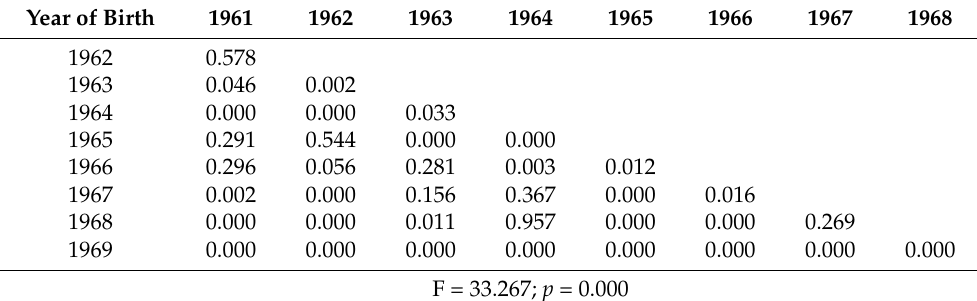
Table 2. Differences in body height values presented by year of birth.